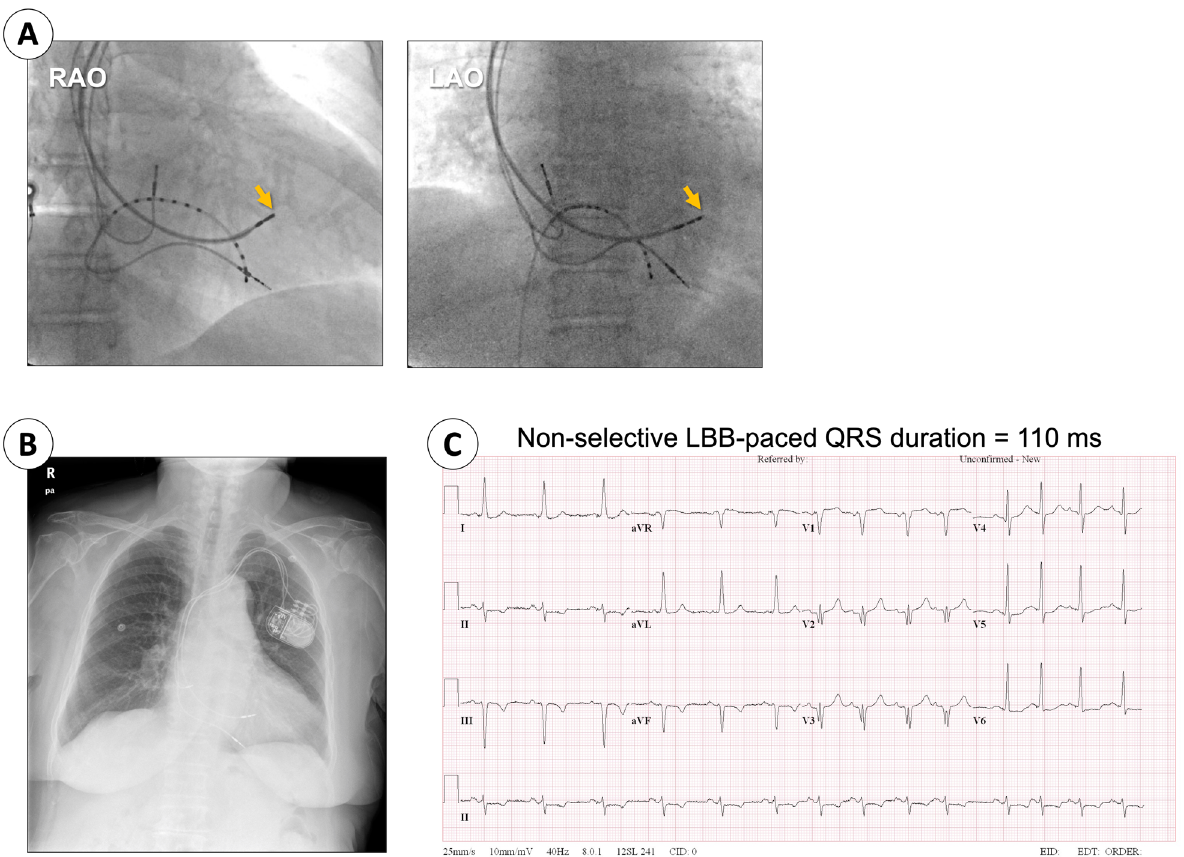
Fig. 4 Results of LBBAP. A , B Old ventricular lead was abandoned, and a new ventricular lead was used for LBBAP (yellow arrow: the pacing lead for LBBAP). C LBB‑paced QRS duration was 110 ms. LAO left anterior oblique view, LBB left bundle branch, LBBAP left bundle branch area pacing, LVAT left ventricular activation time, RAO right anterior oblique